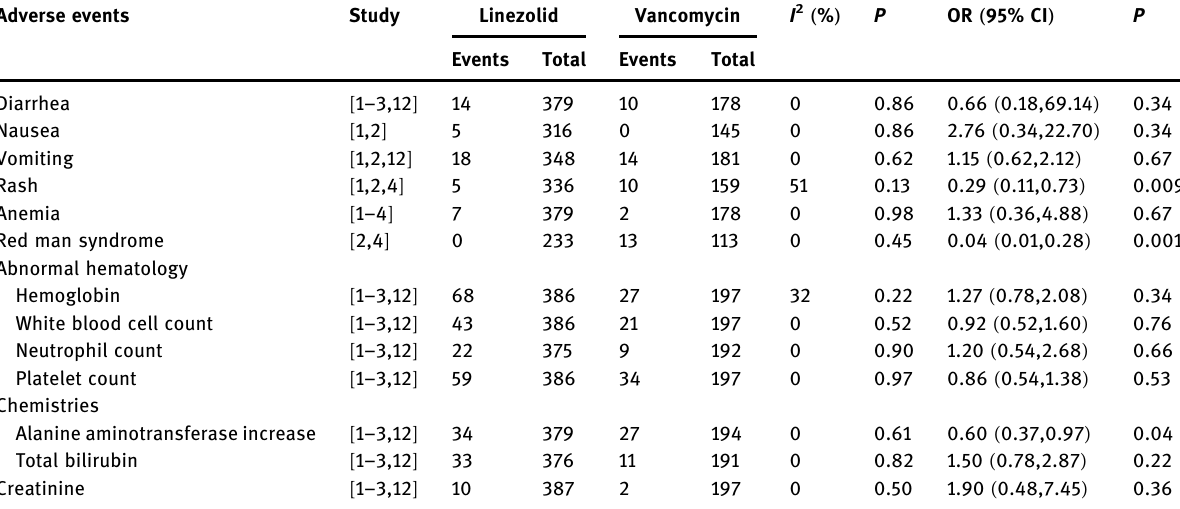
Table 2: Safety assessment for treatment of resistant Gram - positive infections in children Adverse events